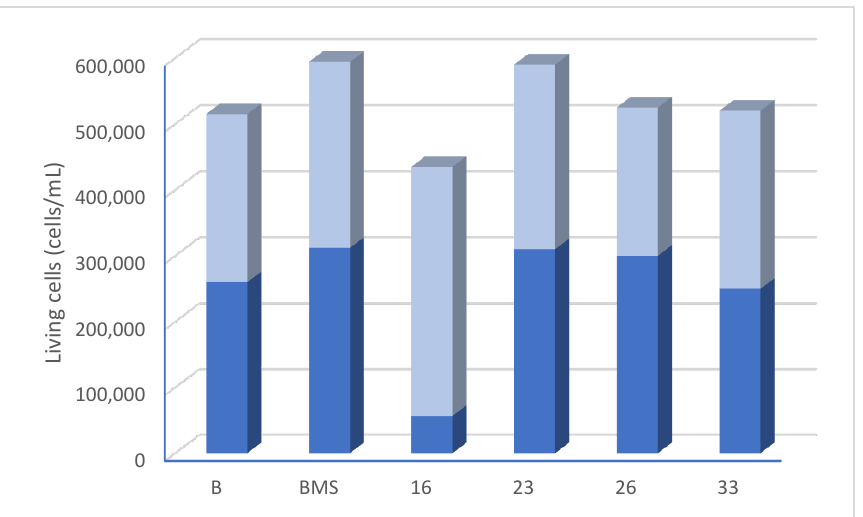
Figure 7. Percentage of Jurkat T cell proliferation and population distribution (%) co-cultured with HT-29. Data are representative of five experiments.